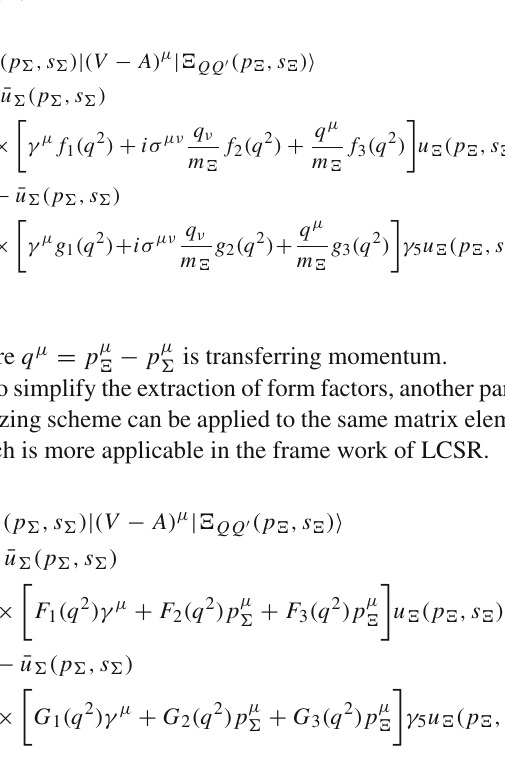
J P Baryon Quark content S π h